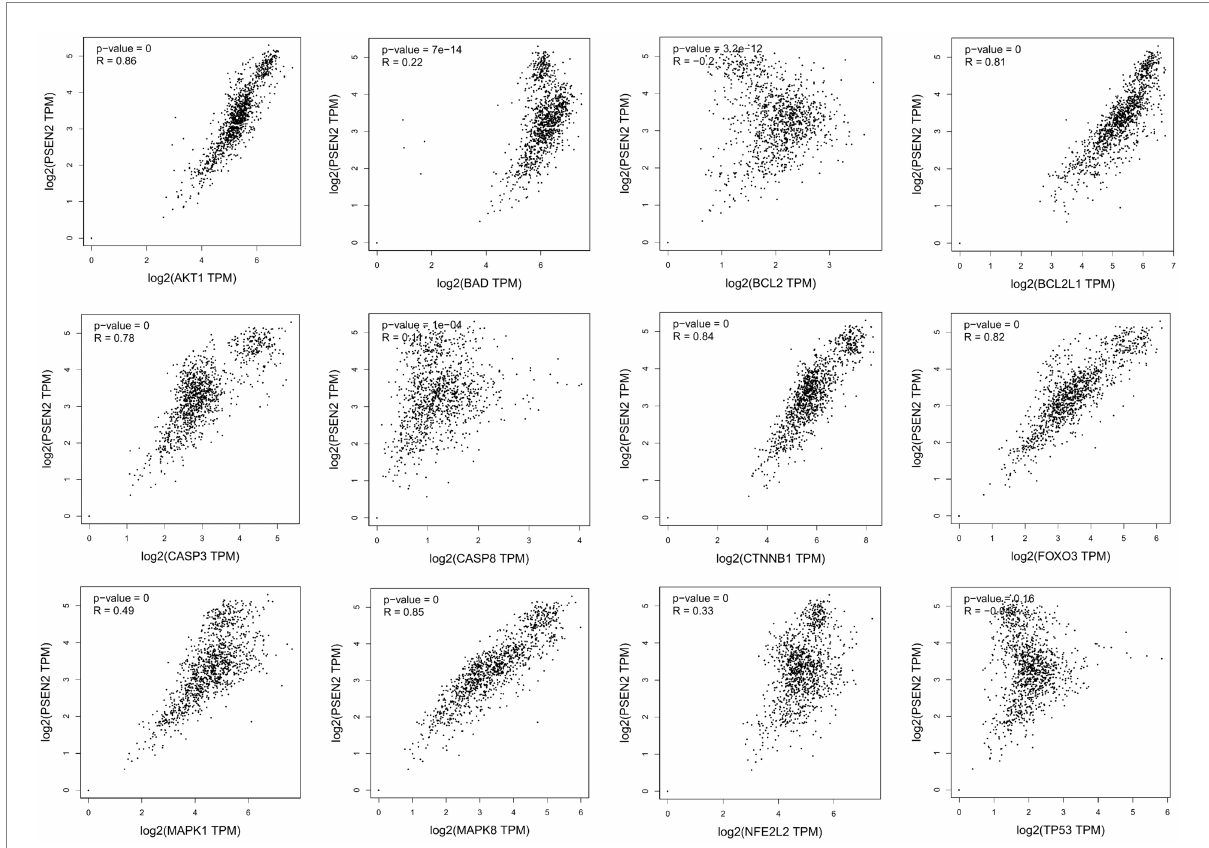
FIGURE 7 Analysis of the correlation between 12 key targets of Cordycepin and the pathogenic gene of Alzheimer’s disease